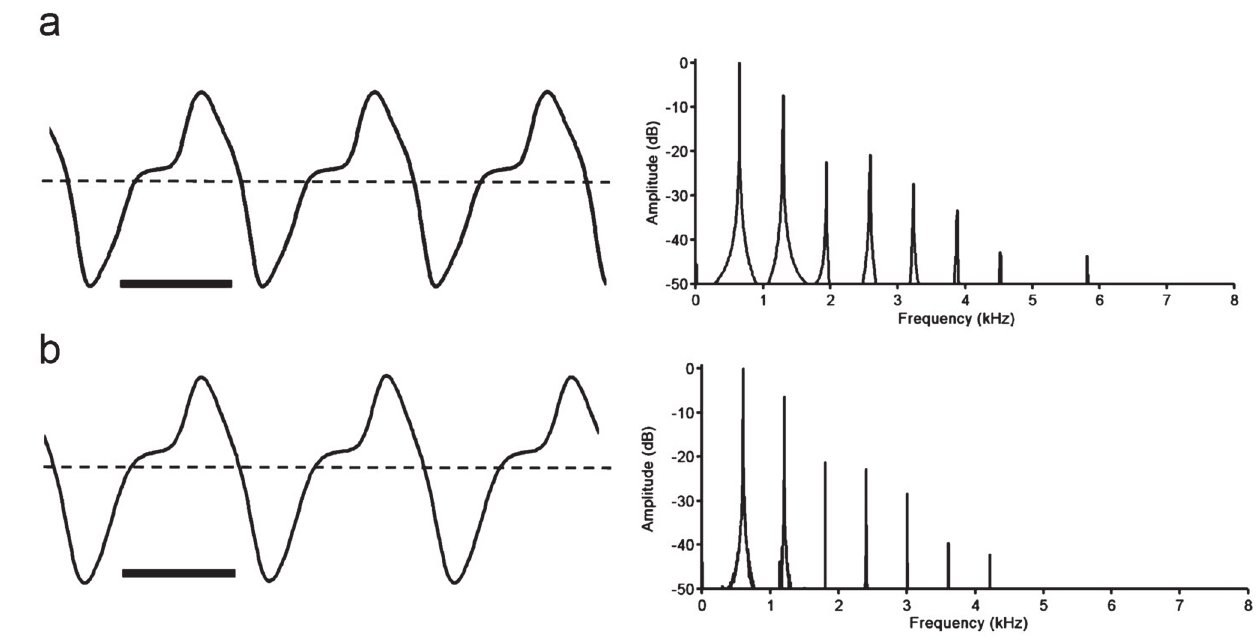
Fig. 4. Electric Organ Discharge (EOD) waveform (left) and Power Spectral Density (PSD) (right) of Apteronotus magdalenensis . ( a ): IAvH-P 9836, WC 2005-09-27-01, male, 360 mm TL, Nikolsky gonad stage 4 (fully mature). ( b ): IAvH-P 7026, WC 2005-09- 27-03, female, 326 mm TL, Nikolsky gonad stage 4 (fully mature). Waveforms are plotted head-positivity upwards, time on abscissa (scale bar = 1 ms), voltage on ordinate, horizontal dashed line = 0 volts. PSD were computed by 65536=point fast Fourier transform from 3s digital recordings. Amplitude on ordinate is scaled so that the peak power frequency is